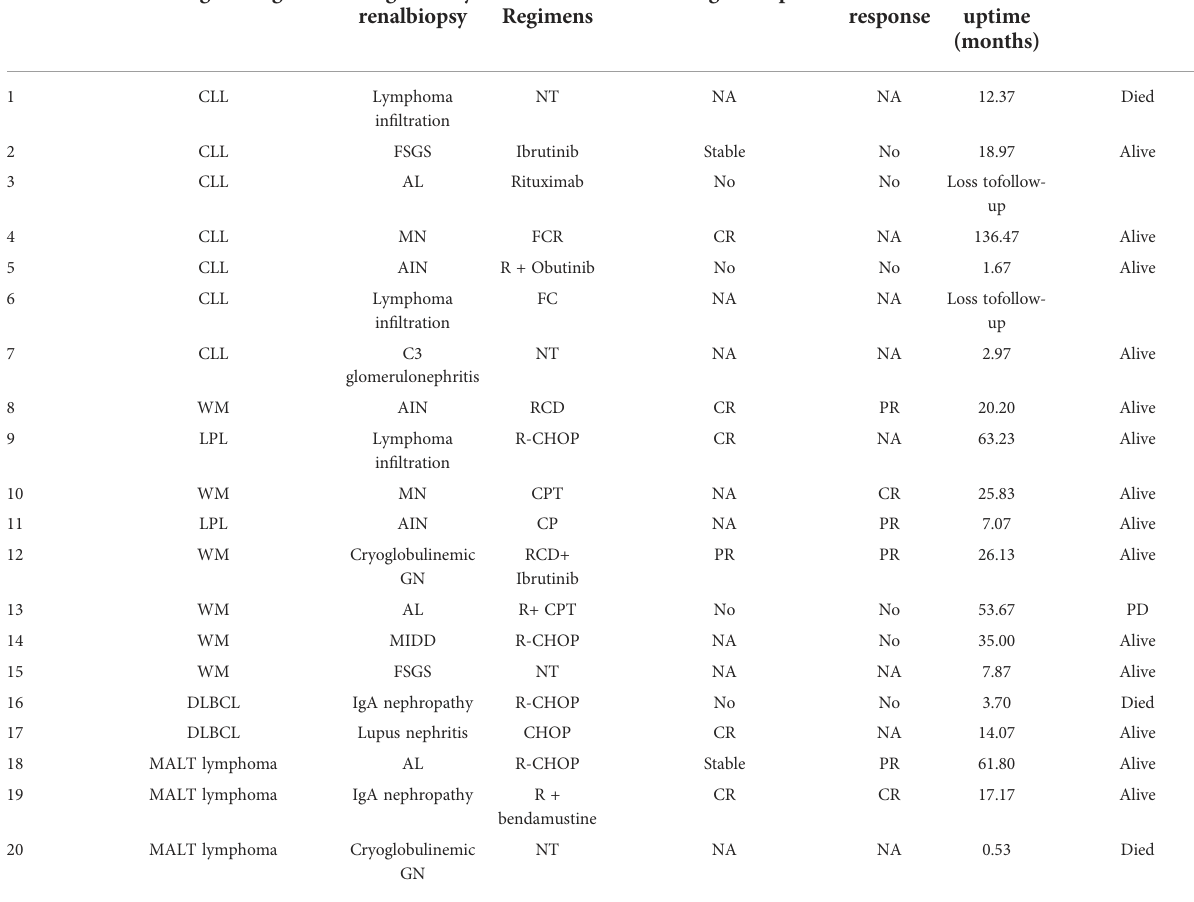
TABLE 3 Treatment Regimens and Outcomes. number Haematologicaldiagnosis Diagnosis by